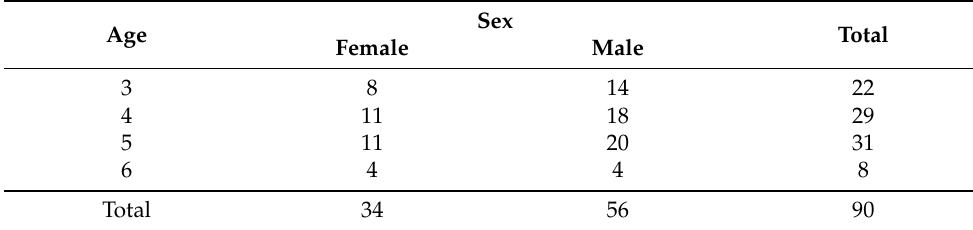
Table 1. Distribution of subjects’ ages and